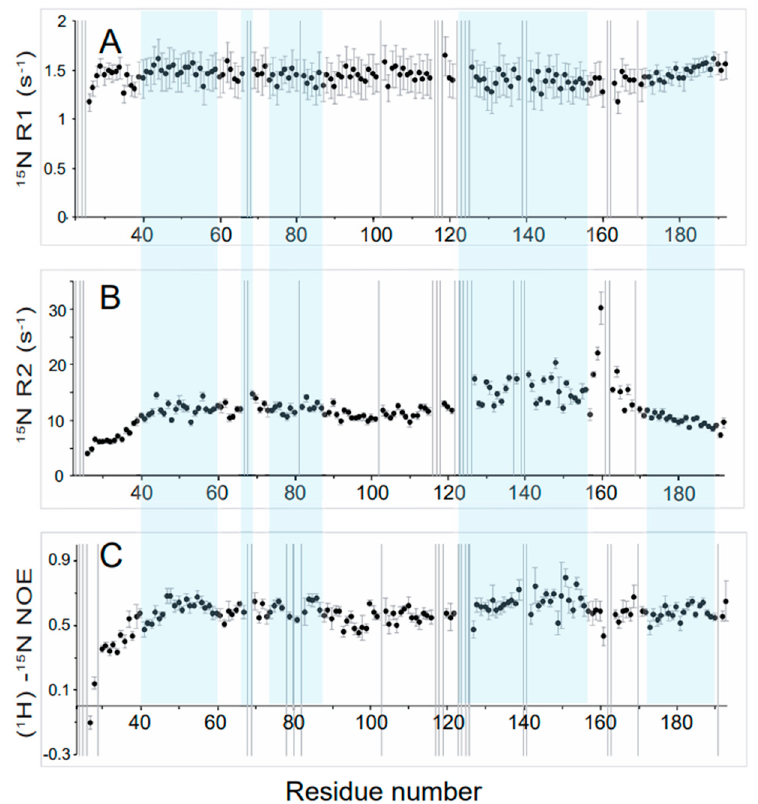
Figure 4. Relaxation rates and backbone dynamics of Nter-BsRNaseY. Plots of the 15 N longitudinal relaxation rate R 1 ( A ), 15 N transverse relaxation R 2 ( B ), heteronuclear { 1 H}- 15 N NOE, and ( C ) param- eters obtained at 950 MHz 1 H and 303K as a function of residue number. The unassigned residues of Nter-BsRNaseY are represented by vertical grey lines. The helices predicted by TALOS-N are highlighted in light